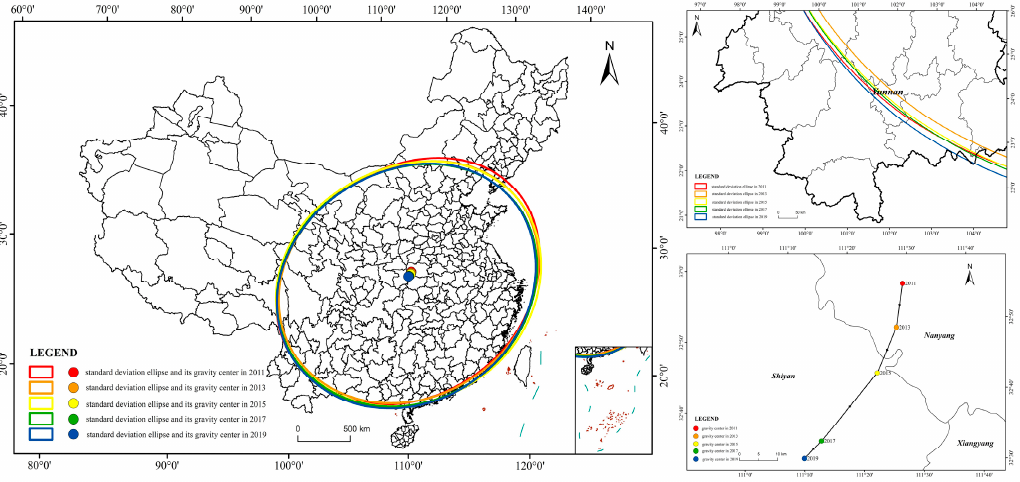
Figure 6. Standard deviation ellipse of agricultural Tfpch and its gravity center migration trajec- tory.